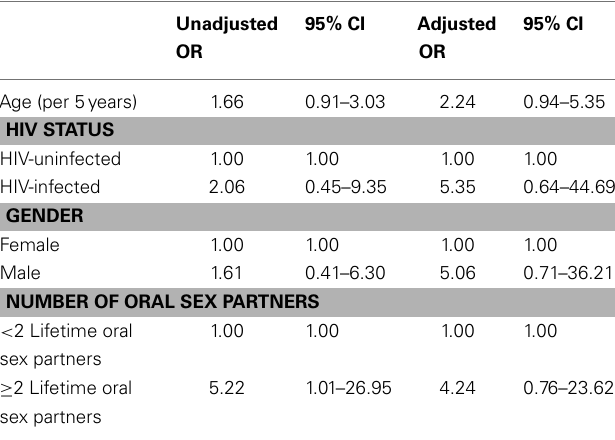
Table 4 | Unadjusted and adjusted odds ratios of oral HPV infection ( n = 68)